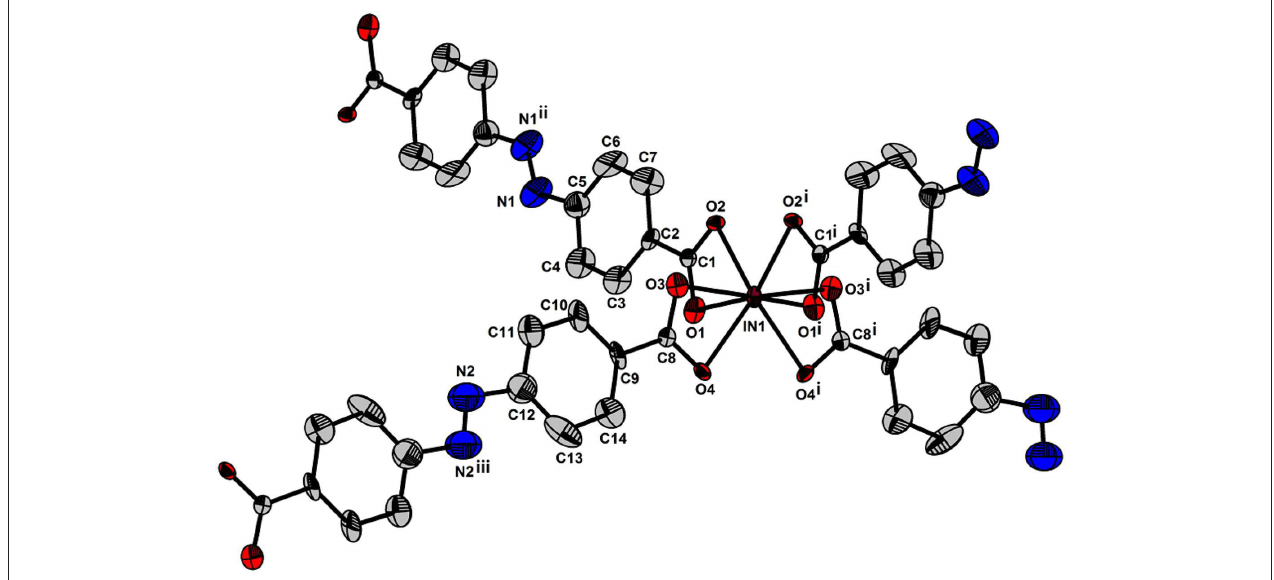
FIGURE 5 | PXRD pattern of as-prepared I (blue) and simulated data (red). The simulated pattern is calculated from X-ray structure using Mercury (ver. 4.1.0) with a full-width half maximum (FWHM) value of 0.2. No preferred orientation is considered.